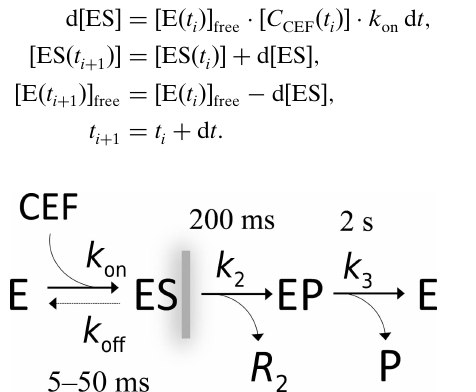
Figure 3 Simplified enzymatic cycle of, and the timescales associated with, the reaction of BlaC with CEF. CEF is delivered to the crystals by diffusion. It noncovalently binds to the free BlaC enzyme (E) to form the enzyme– substrate complex (ES). The acyl intermediate EP, which is covalently bound to Ser70, is formed within (cid:6) 200 ms. The leaving group R 2 is cleaved off the CEF. The modified CEF (EP) is hydrolyzed and released as product (P) and the free enzyme is recovered within about 2 s. In this paper, only the formation of the ES complex up to 50 ms (gray, blurred vertical line) was explored.